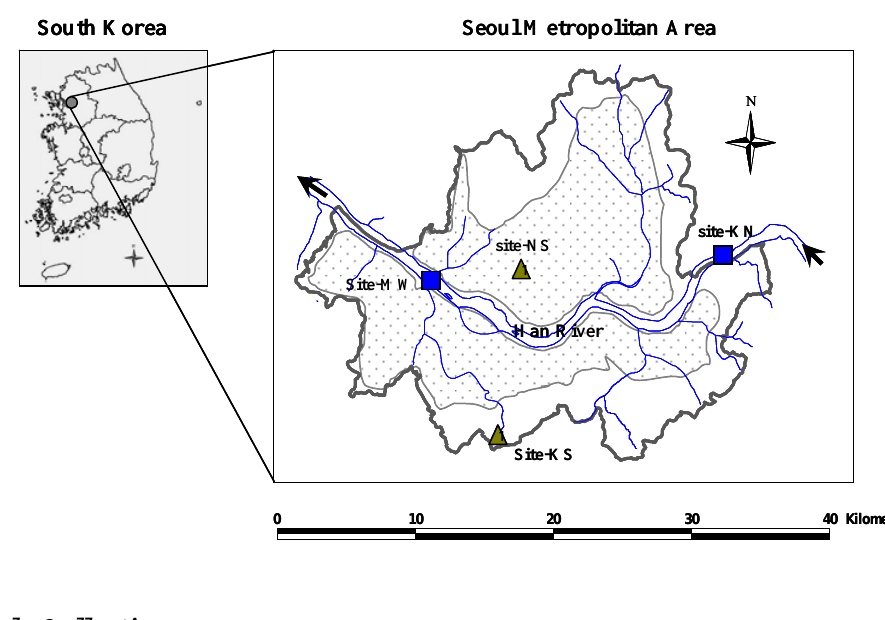
Figure 1. The study area and the sampling locations (NS and KS for terrestrial samples, KN and MW for aquatic samples). Dotted area represents the population-dense